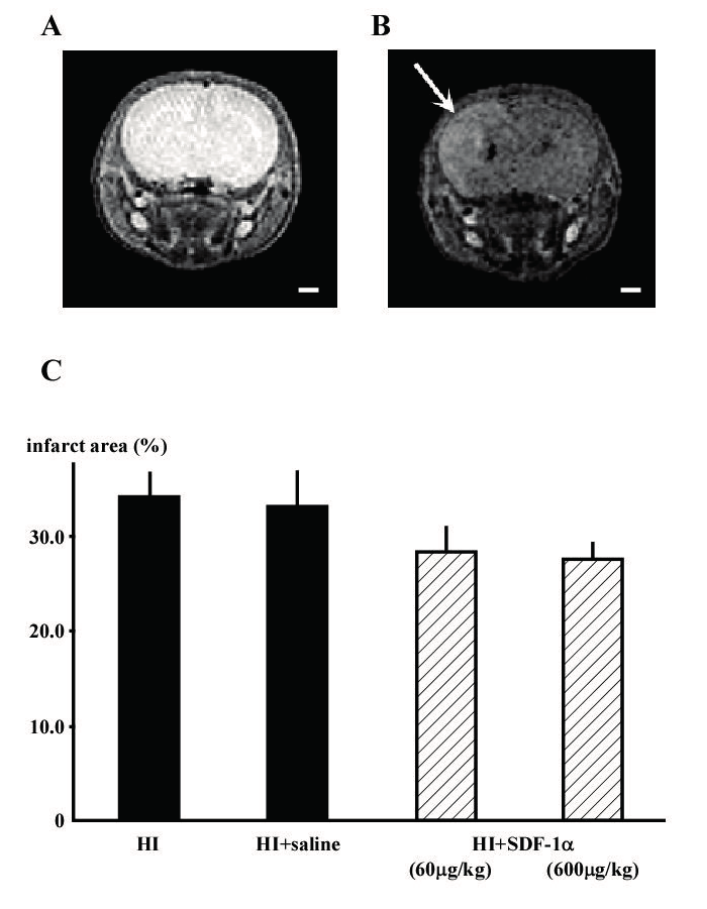
Figure 1. T 2 -weighted MRI images from P14 showing that surgery can produce HI in neonatal rat brains. Coronal cerebral sections from rats in the ( A ) sham and ( B ) HI groups. Infarction was observed in the WM (white arrow); and ( C ) Infarct area was slightly reduced by treatment with 600 μ g/kg SDF-1 α . Bar is